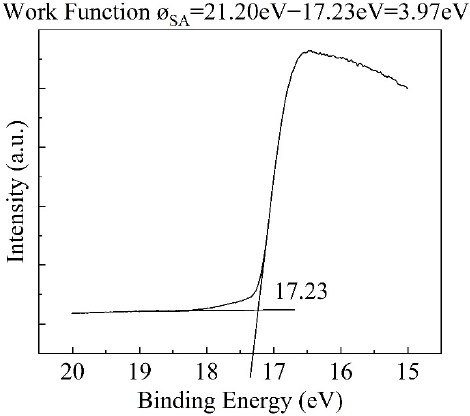
Figure 3. The valence-band spectra pattern of the 0.2 wt.% Y 2 O 3